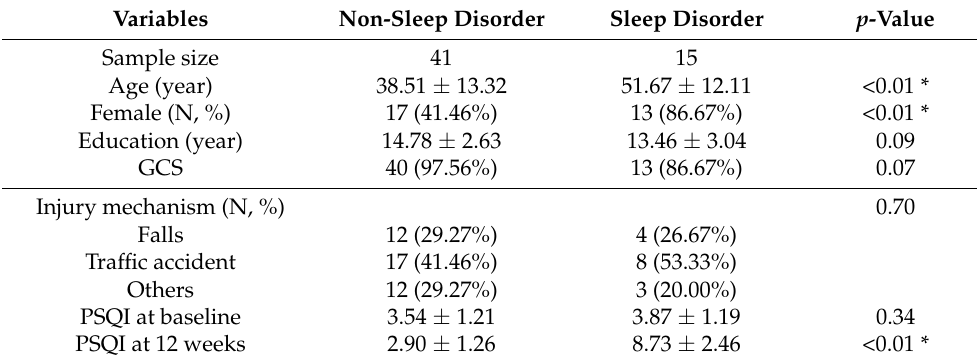
Table 1. Baseline characteristics between sleep-disorder and non-sleep-disorder mTBI patients (mean ± standard